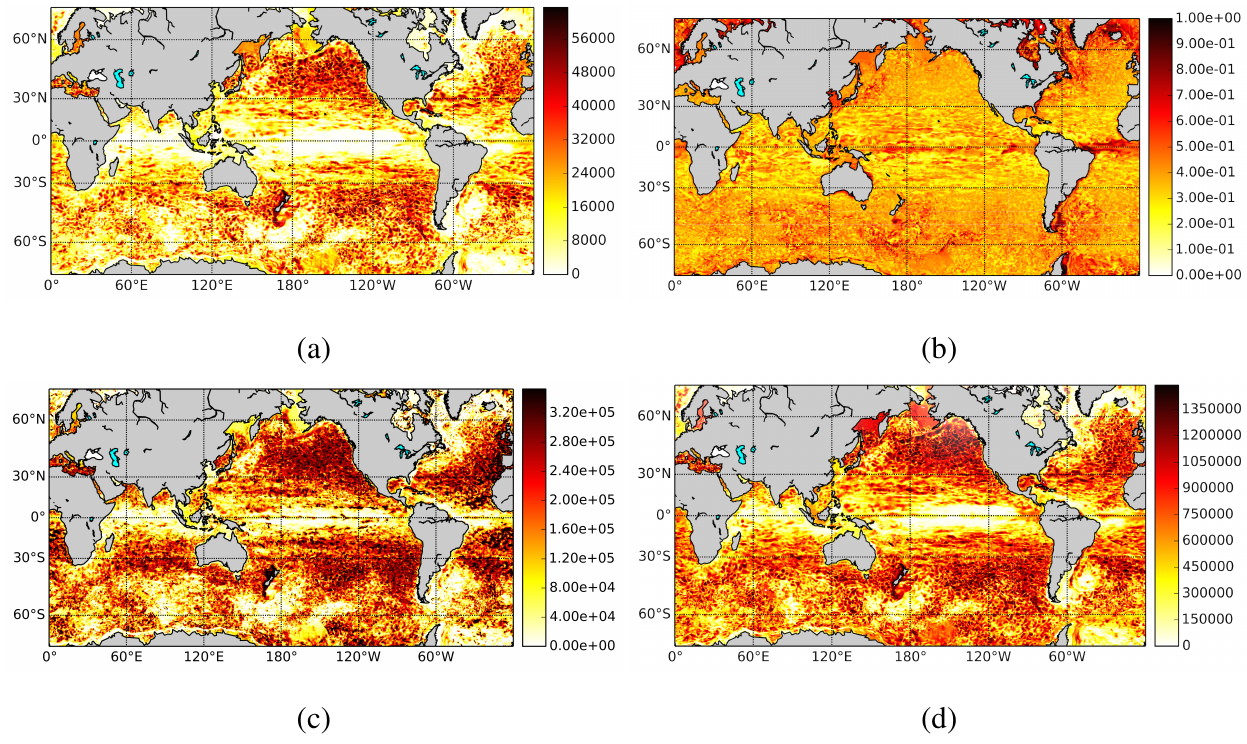
Figure 6. (a) Degree, (b) clustering and (c) betweenness for the SSH POP data interpolated on the 0 . 4 ◦ grid and a threshold of τ = 0 . 5. (d) Degree field for the 0 . 1 ◦ grid and a threshold τ = 0 . 4. Here the reconstructed network has 4 . 7 × 10 6 nodes and 1 . 4 × 10 12 edges. Fig. 9: (a) Degree, (b) Clustering and (c) Betweenness for the SSH POP data interpolated on the 0 . 4  grid and a threshold of ⌧ = 0 . 5 . (d) Degree field for the 0 . 1  grid and a threshold ⌧ = 0 . 4 ; here the reconstructed network Table 2. A single edge’s size in memory when using the indexed 10 6 nodes and 1 . 4 10 12 edges. has 4 . 7 edge list used in igraph compared to its corresponding size when ⇥ ⇥ applying Par@Graph. Additionally, a vertex in igraph is repre- sented by 16 bytes in memory, whereas it needs only 4 bytes in